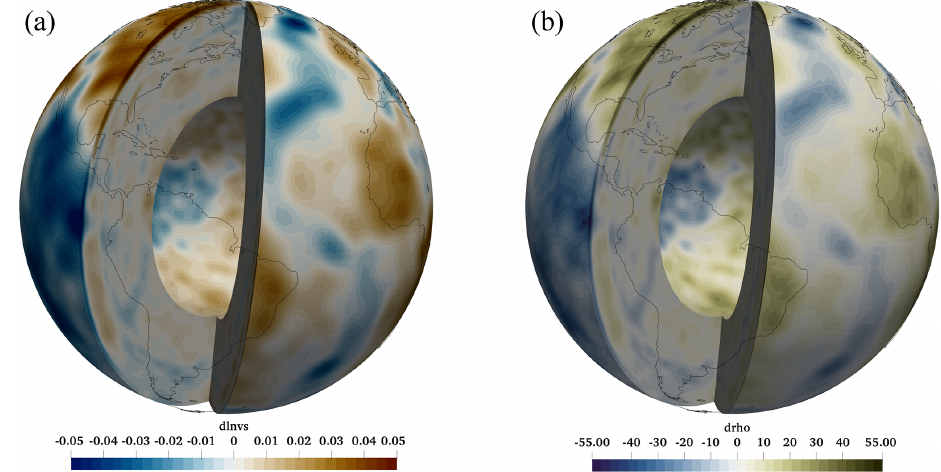
Figure 10. HS06 grid with 64 layers and level = 64. (a) δ ln V s at the surface of the model ( R = 6346km) and at depth down to the core mantle boundary ( R = 3480km); (b) absolute density variation δρ (kgm − 3